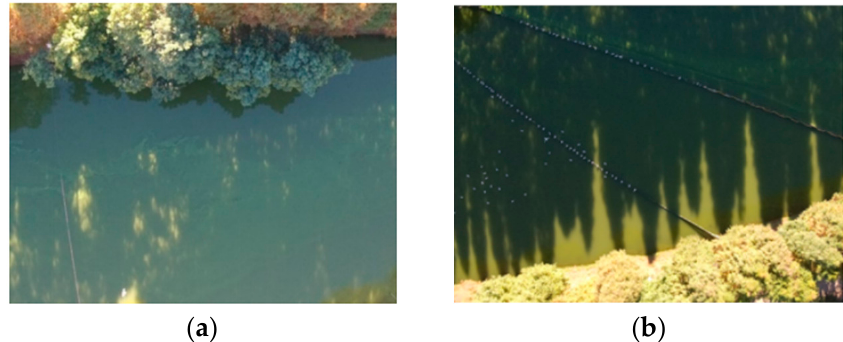
Figure 3. Complex river scenes: ( a ) reflection case; ( b ) shadow case.